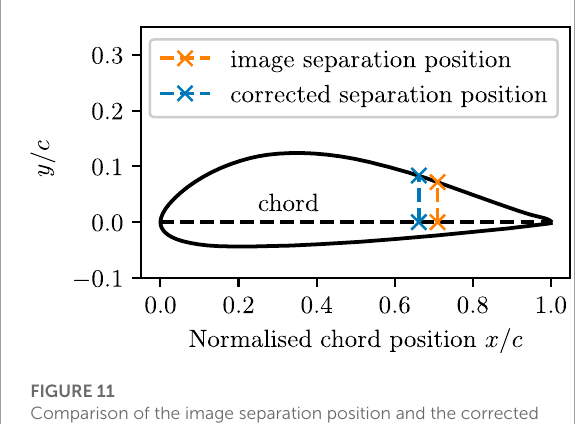
FIGURE 11 Comparison of the image separation position and the corrected separation position using the geometric alignment algorithm for the rotor blade geometry at the rotor radius of 28.7 m.